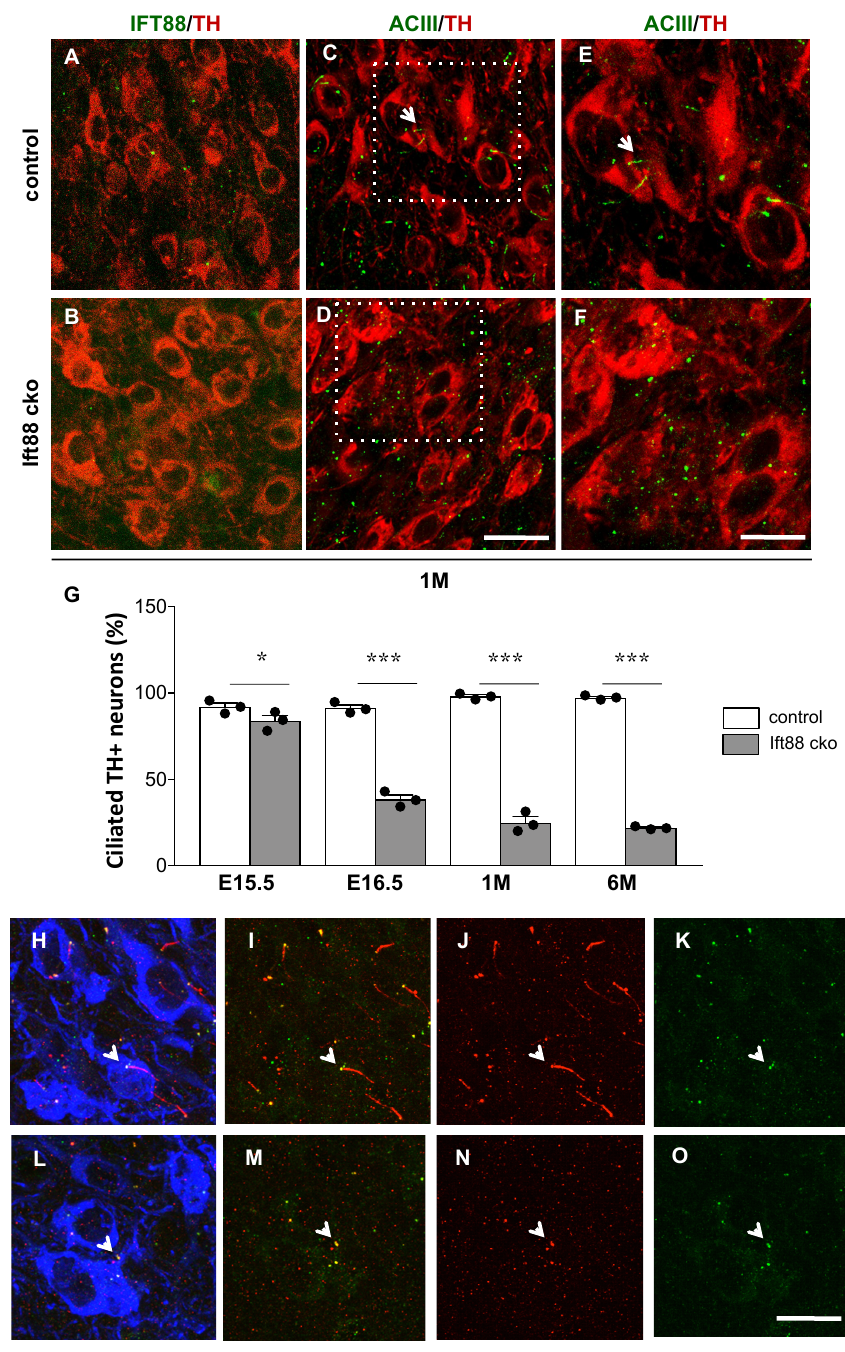
Figure 1. Conditional ablation of Ift88 results in the loss of primary cilia in ventral midbrain DA neurons. ( A , B ) Representative confocal images of coronal midbrain sections at 1 month showing loss of IFT88 protein in DA neurons by immunofluorescence with an IFT88-specific antibody (green) and a TH-specific antibody (red), as a marker of DA neurons. ( C , D ) Representative confocal images of coronal midbrain sections at 1 month showing loss of primary cilia by immunofluorescence with the